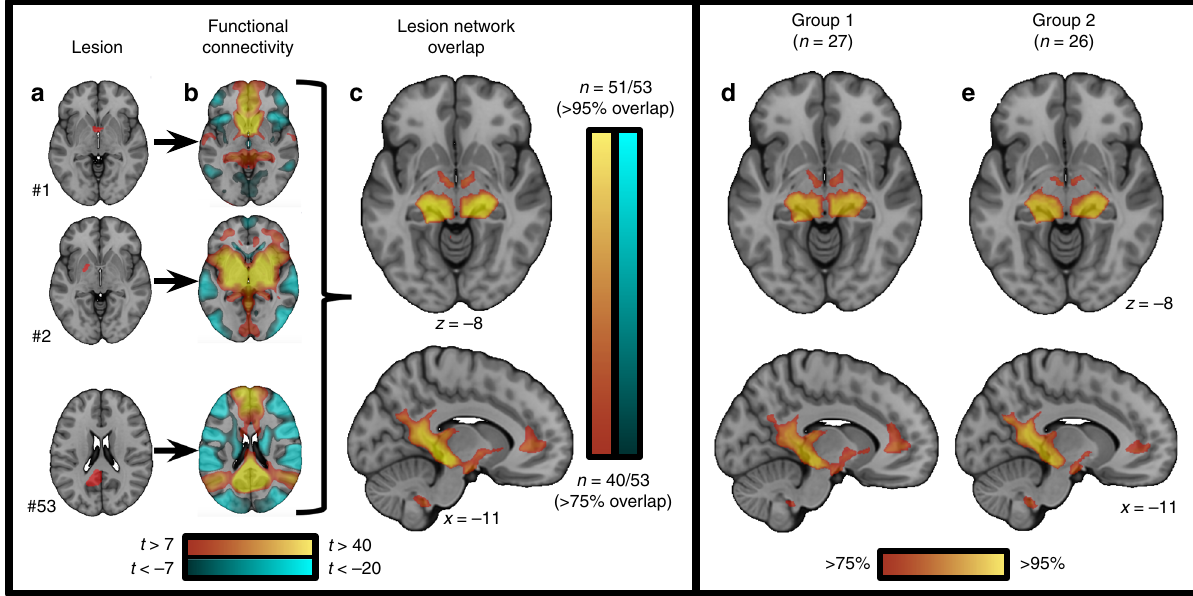
Fig. 2 Lesion network mapping method and split half replication. Individual amnesia-causing lesions were mapped to a common brain template ( a ). Connectivity between each lesion location and the rest of the brain was computed using resting state functional connectivity from 1000 healthy control subjects ( b ). Positive correlations with the lesion location are shown in warm colors while negative correlations (anticorrelations) are shown in cool colors. Individual lesion network maps were thresholded, binarized, and overlapped to identify connections common to the lesion locations ( c ). Random splitting of our amnesia-causing lesion sample into two cohorts demonstrates high reproducibility of lesion network overlap ( d , e ). Additional iterations of random splitting were similar (Supplementary Figure 2)